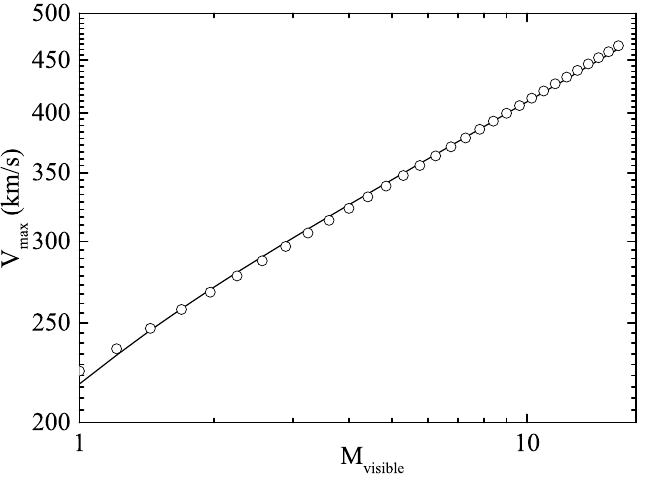
Figure 4. Rotation velocity of a galaxy vs. its visible mass for the model in Equations (27)–(29) in a logarithmic scale. The velocity is given in km/s and the mass in units of the mass of the Milky Way. The solid line is the result for the model and the circles correspond to the linear fitting in Equation